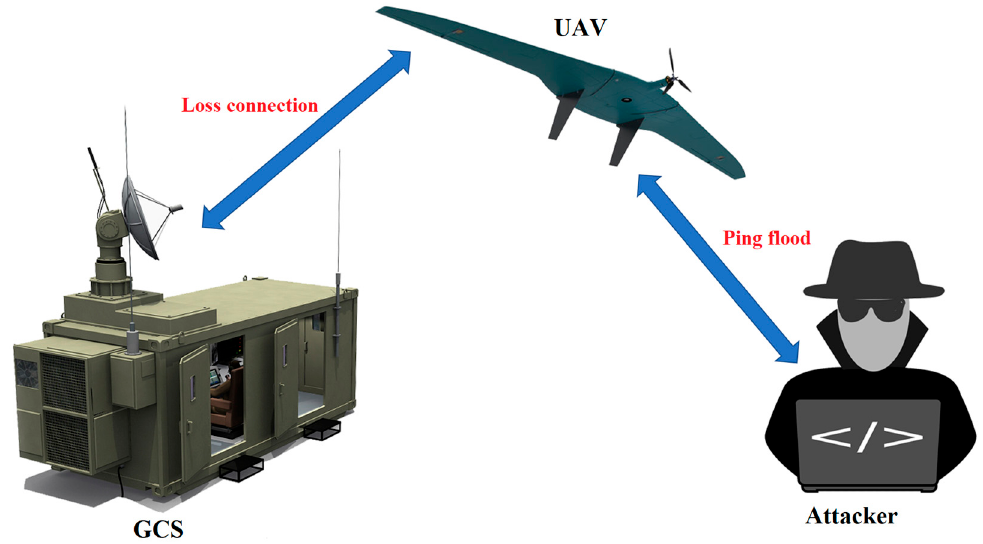
Figure 4. UAV DoS scheme.